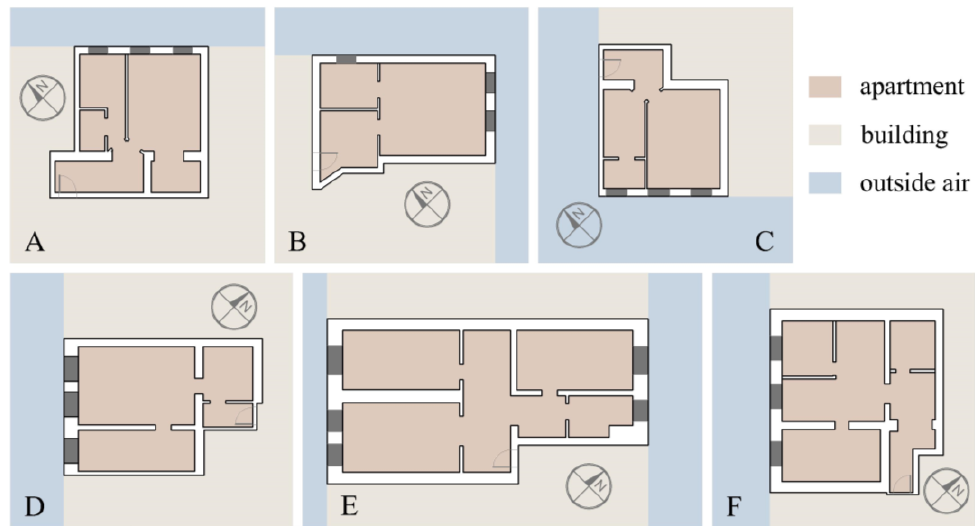
Figure 1. Floor plans of the residential units: ( A – F ) symbol of the apartment.